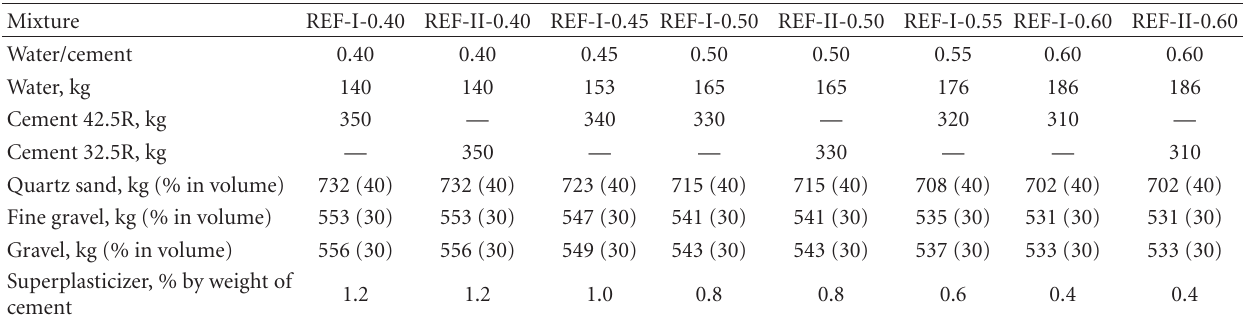
Table 2: Mixture proportions of concretes made of 100% virgin aggregates.